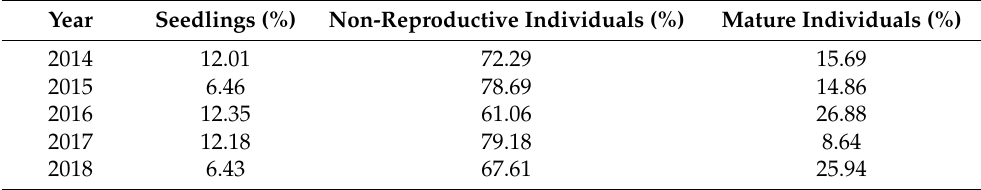
Table 3. Percentage of seedlings, non-reproductive and mature individuals of Micromeria browiczii during monitoring